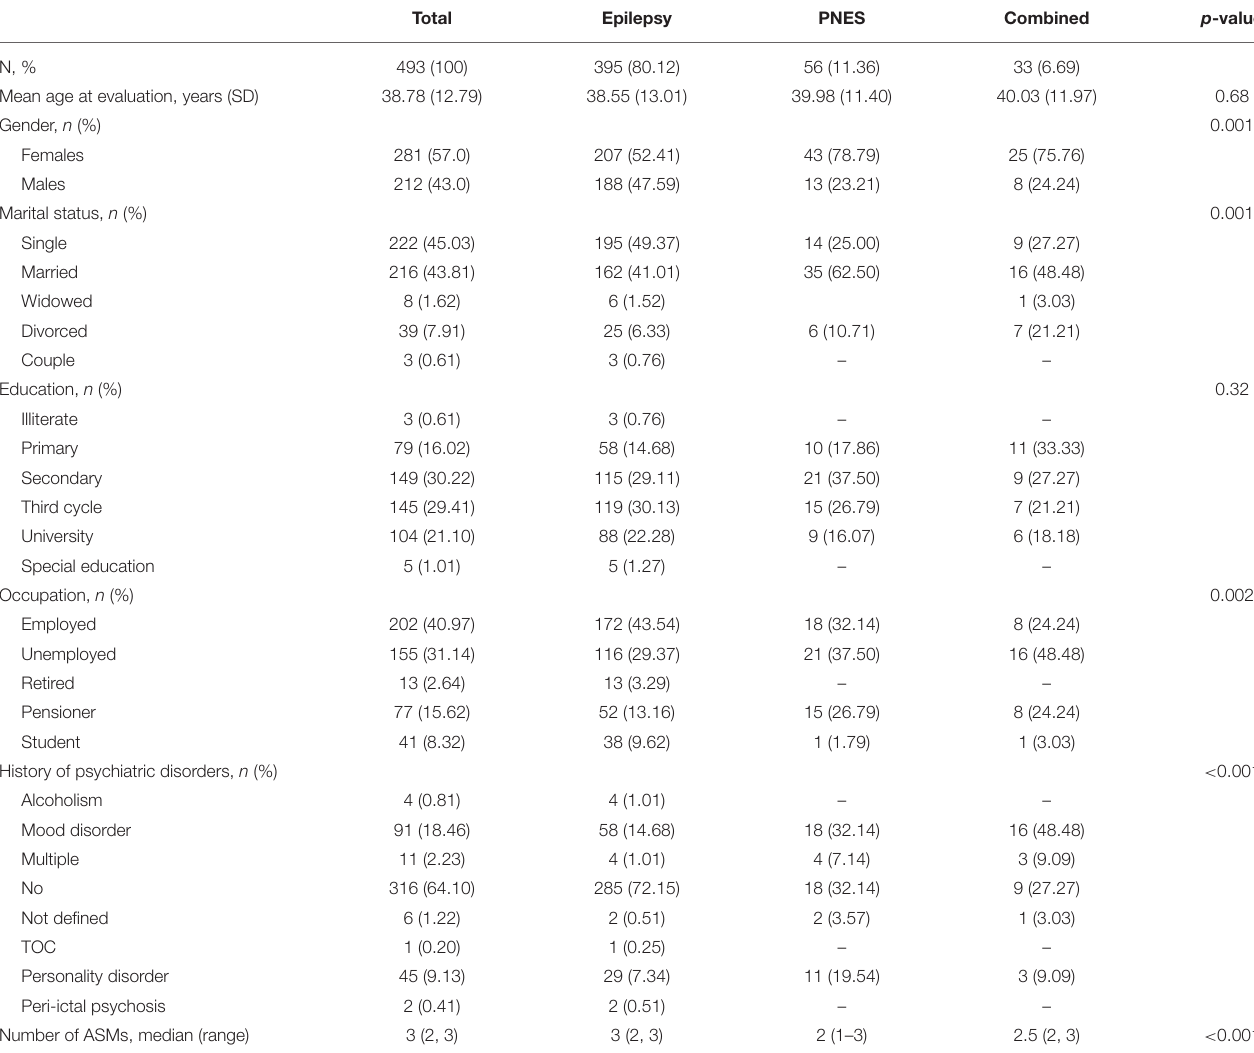
TABLE 2 | Clinical and sociodemographic characteristics of the patients included in the analysis ( N = 493).